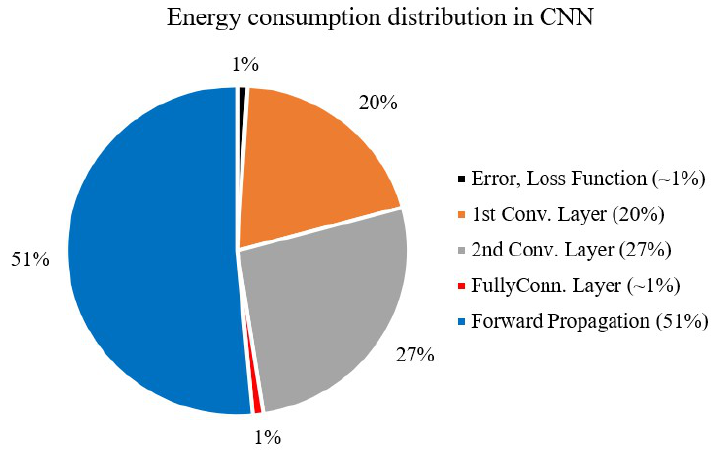
Table 3. Convolutions used in MPGA optimization and back-propagation in the first layer.